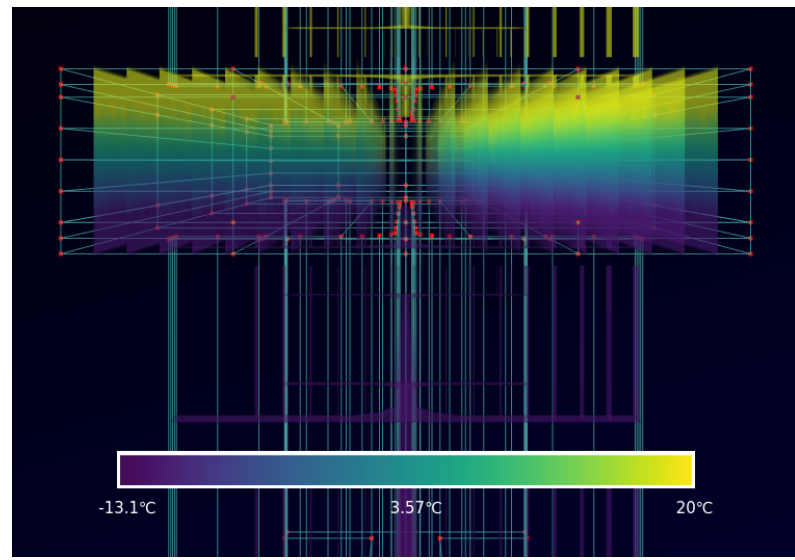
Figure 4. The solution of the I-beam temperature